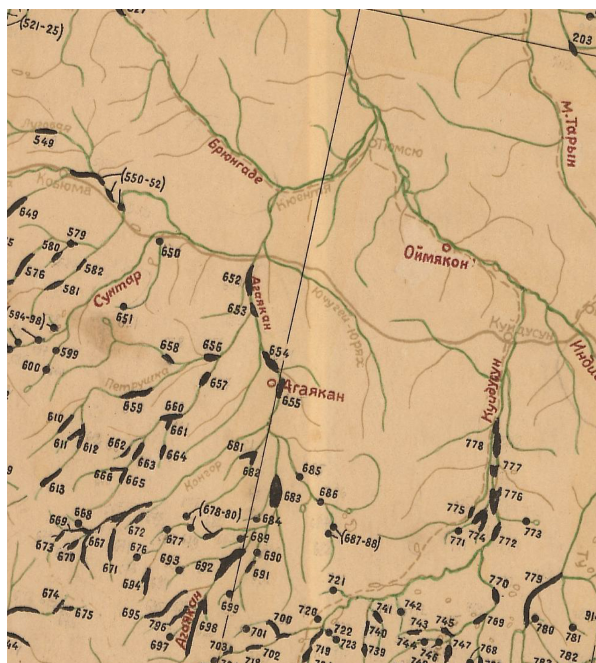
Figure 2. A section of the Cadastral map of the North-east USSR from 1958 (sheet 7, upper reaches of the Indigirka River – the basins of the rivers Suntar, Agayakan and